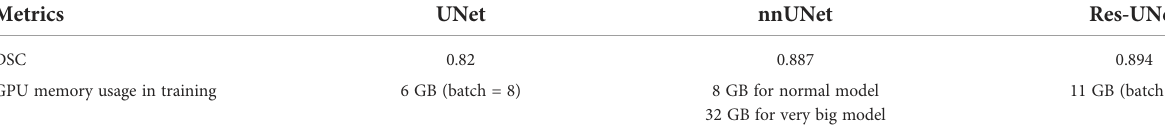
TABLE 1 Different networks ’ dice similarity coef fi cient (DSC).